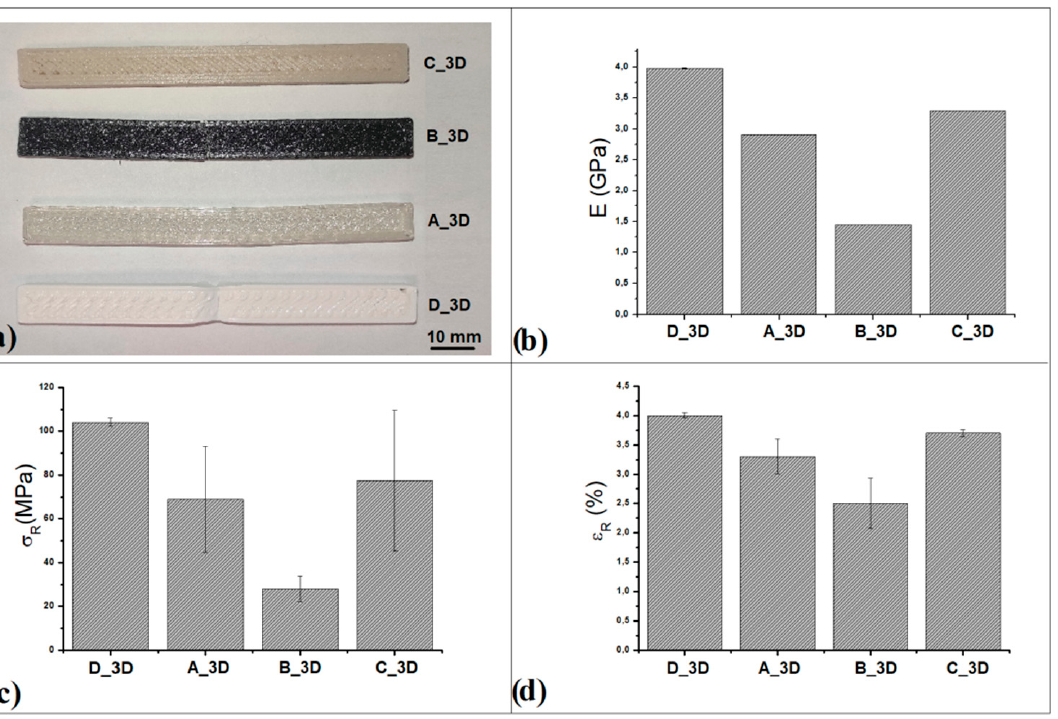
Figure 6. ( a ) 3D bars: D_3D, A_3D, B_3D and C_3D. Mechanical flexural properties: ( b ) flexural modulus of elasticity (GPa), ( c ) flexural stress (MPa), ( d ) flexural strain (%).